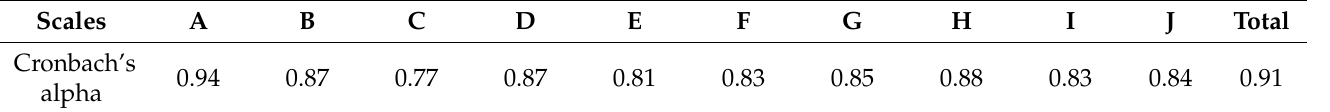
Table 3. Reliability of the scales of the Galician